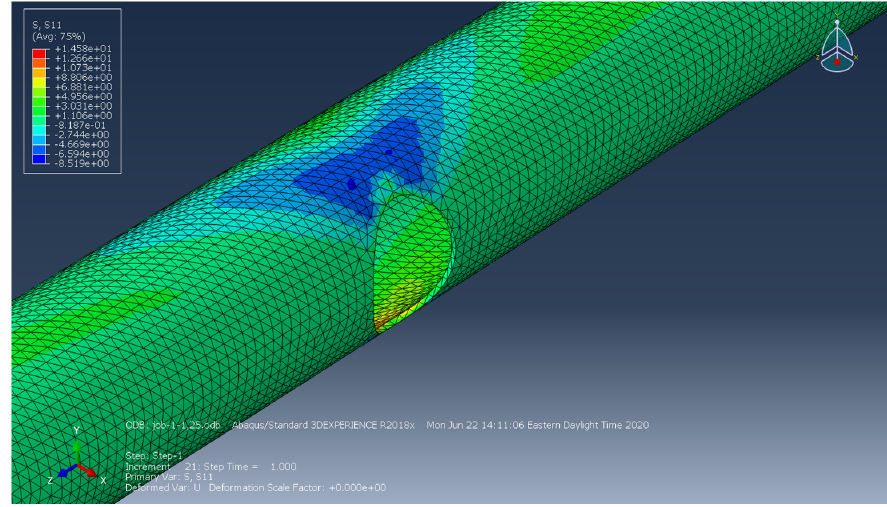
Figure 21. Aspect ratio 1-1.25 in transverse (X) direction.